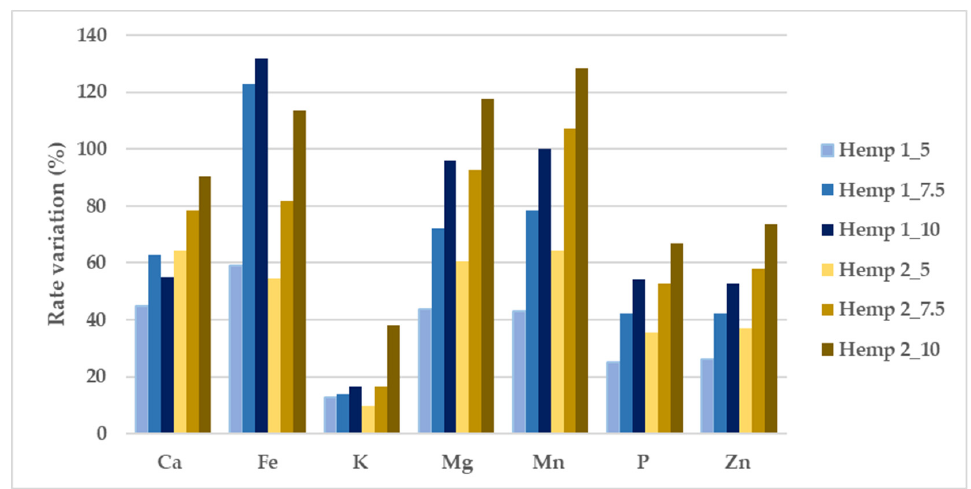
Figure 1. Percentage variation (%) of the hemp-enriched pasta samples vs the CTRL (durum wheat semolina cv. Ciclope).